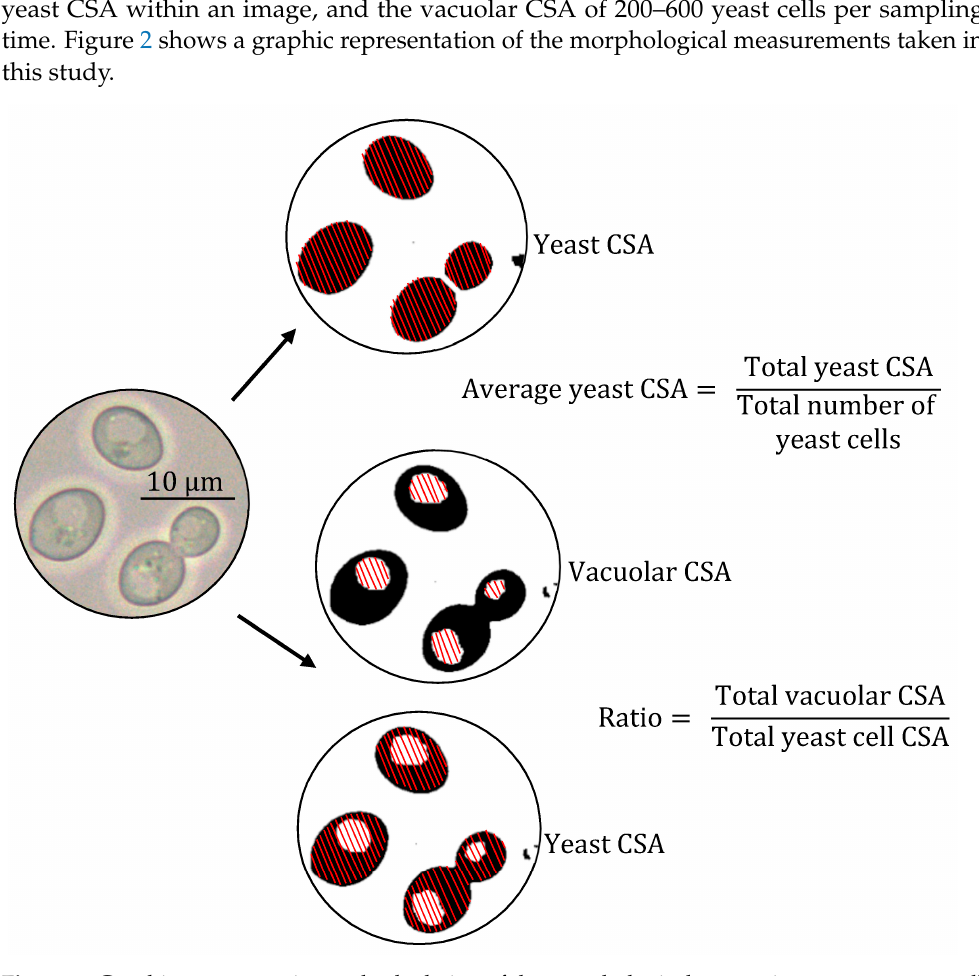
Figure 2. Graphic representation and calculation of the morphological properties: average yeast cell cross-sectional area (CSA) and vacuolar ratio. The left circle image is a microscope image taken during fermentation (1000 × ). Right circle images are after image processing for the automated analysis with the red shading representing the variable